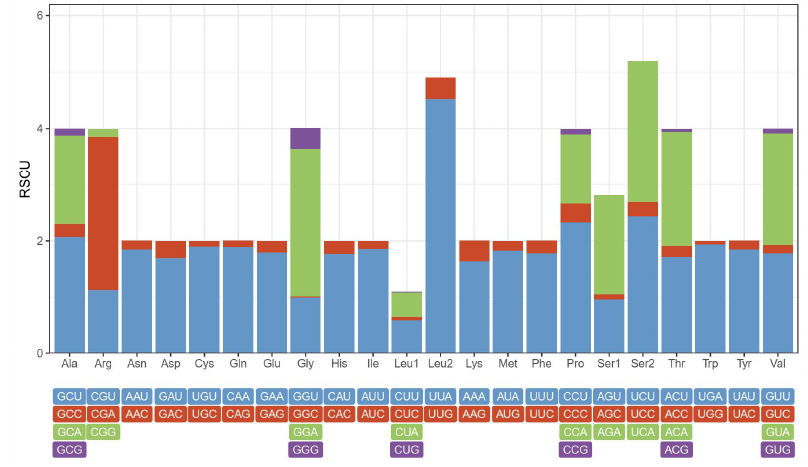
Figure 3. Relative synonymous codon usage (RSCU) of G. orientalis mitogenome.